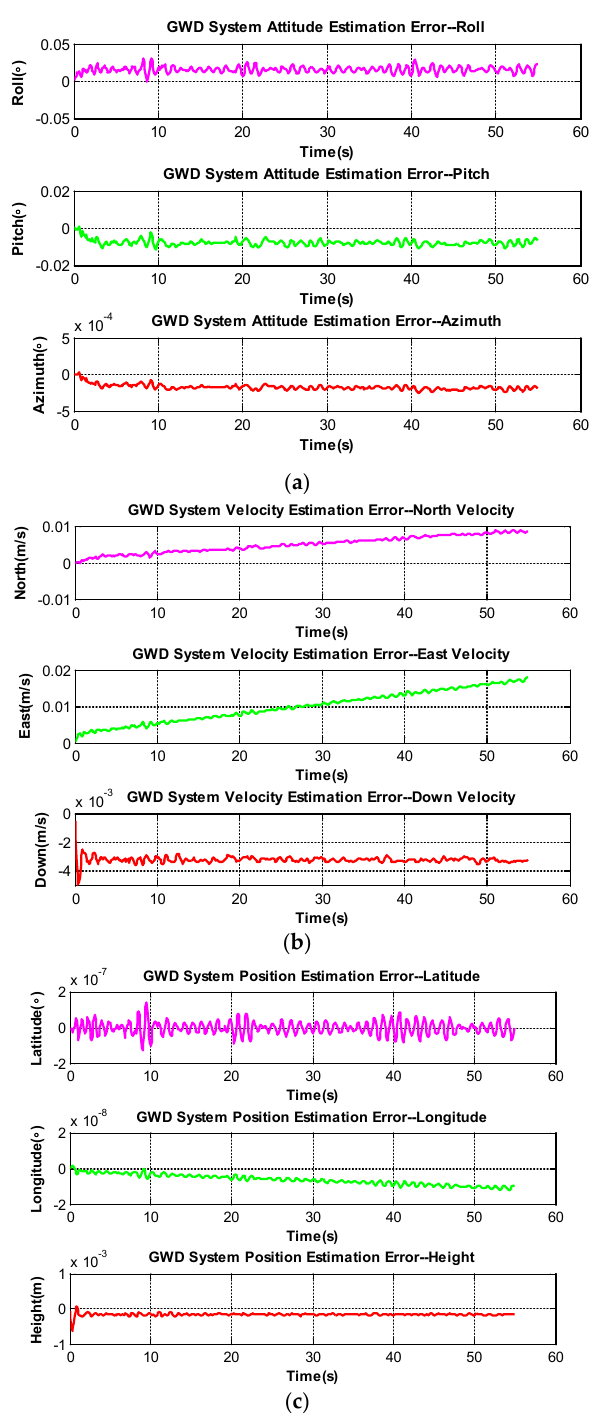
Figure 13. ( a ) Kalman filter position estimation error; ( b ) Kalman filter velocity estimation error; and ( c ) Kalman filter attitude estimation error.